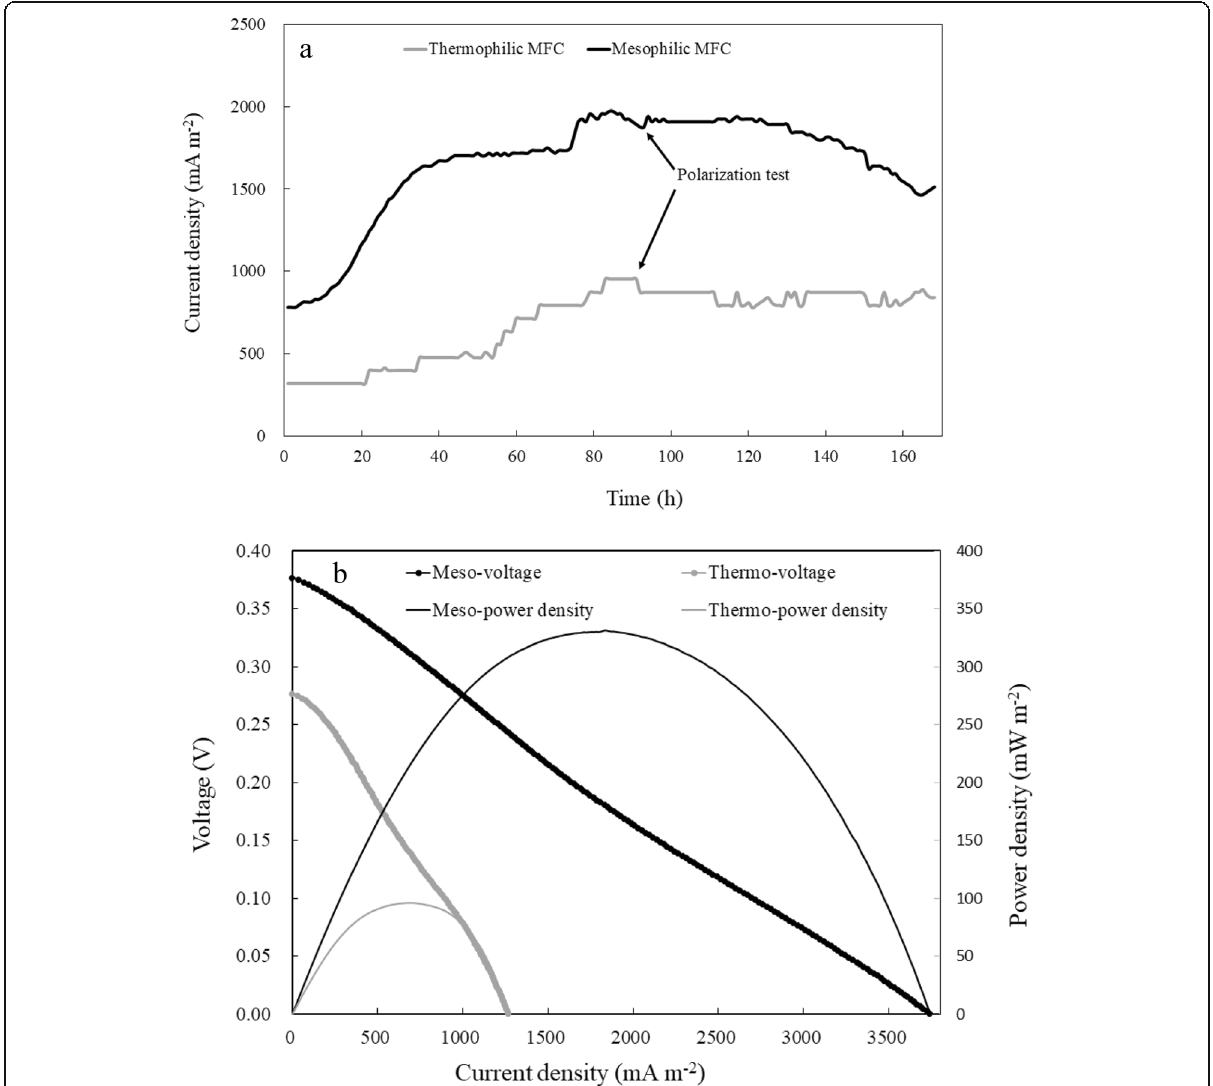
Fig. 2 The current density of the two systems and the time that polarization curve was measured ( a ). The meso-MFC immediately reaches 780 mA m − 2 (based on the cathode area), and gradually increases to plateau at 1900 mA m − 2 ; the current density of the thermo-MFC gradually increases to 875 mA m − 2 . The polarization and power density of the two systems ( b ). The highest voltage is 0.38 V for the meso-MFC and 0.28 V for the thermo-MFC. The highest power densities for the meso-MFC and thermo-MFC are 330 and 105 mA m −